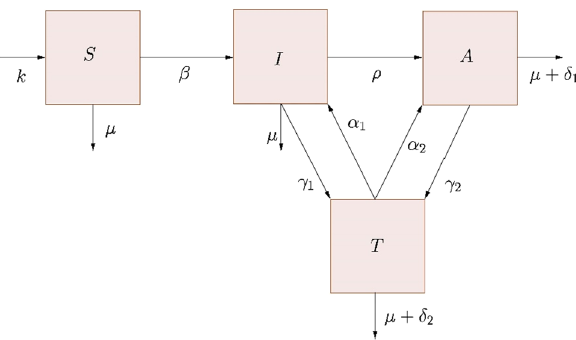
Figure 2. Epidemiological scheme of the HIV/AIDS transmission